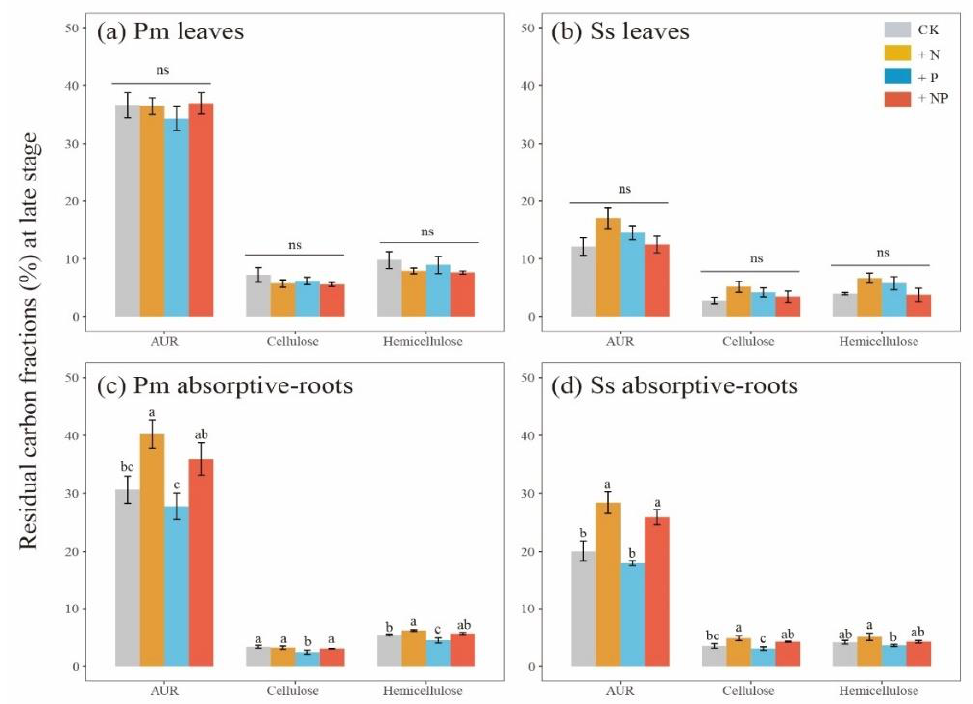
Figure 3. Concentrations of residual carbon fractions in four substrates under different treatments in the 3-year stage of decomposition. Carbon fractions include AUR, cellulose, and hemicellulose. Values are the mean ± SE ( n = 4). Significant differences between means were determined using Tukey’s honestly significant difference test. Different letters indicate significant differences among treatments ( p < 0.05). CK, control; +N, nitrogen addition; +P, phosphorus addition; +NP, combined additions of nitrogen and phosphorus; AUR, acid-unhydrolysable residue; Pm , Pinus massoniana ; Ss , Schima superba